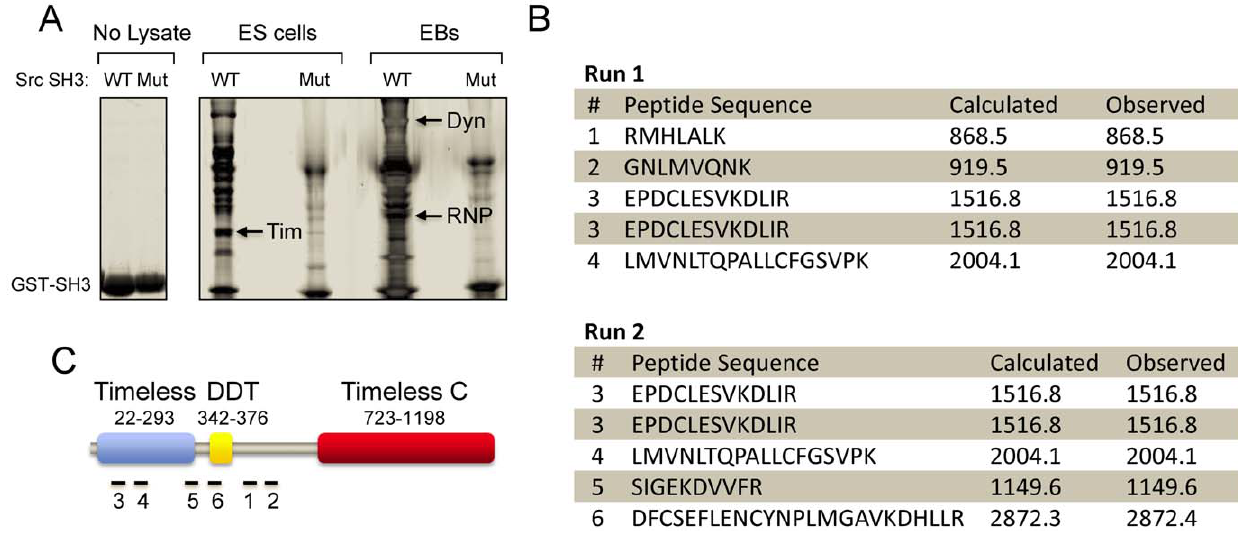
Figure 1. Identification of Src SH3-binding proteins in ES cells and embryoid bodies (EBs). The mouse c-Src SH3 domain as well as a binding-defective control were expressed in bacteria as GST fusion proteins and immobilized on glutathione-agarose beads. Lysates from self- renewing ES cells and 6 day EBs were incubated with the immobilized wild-type and mutant Src SH3 domains, and associated proteins were eluted and resolved by SDS-PAGE (see Materials and Methods). A , Image of a Coomassie blue-stained gel of the purified wild-type (WT) and mutant (Mut) Src GST-SH3 proteins (No Lysate). SH3 target proteins captured from ES cell and EB lysates are indicated in the next four lanes. Unique bands were excised and identified via tryptic fingerprinting and MALDI-TOF MS, including the known Src SH3 interacting proteins hnRNP K (RNP) and Dynamin II (Dyn), as well as a fragment of Timeless (Tim; arrows ). B , Details of the MS data obtained for Tim. The excised band from ES cells in Part A was halved and subjected to two separate MS runs. Tim was the top hit from both runs, with two peptides of identical sequence identified in each case. The sequence as well as the calculated and observed masses for each peptide are shown. C , The six numbered peptides from Part B map within the N- terminal region of the Tim protein. Three major domains of Tim are illustrated, including the N-terminal Timeless region, the DDT (Domain binding homeobox and Different Transcription factors) domain, and the C-terminal Timeless C region.